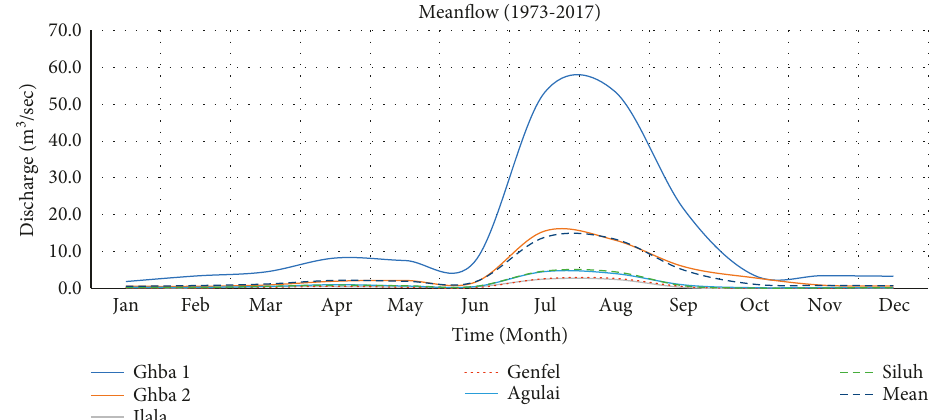
Figure 7: The mean monthly river discharge at six stations in the Ghba